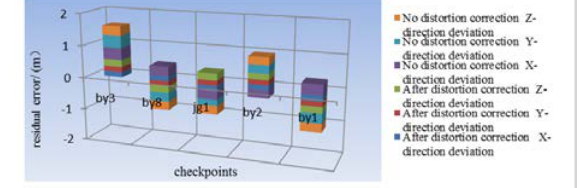
Figure 1. Camera distortion parameters affect data accuracy